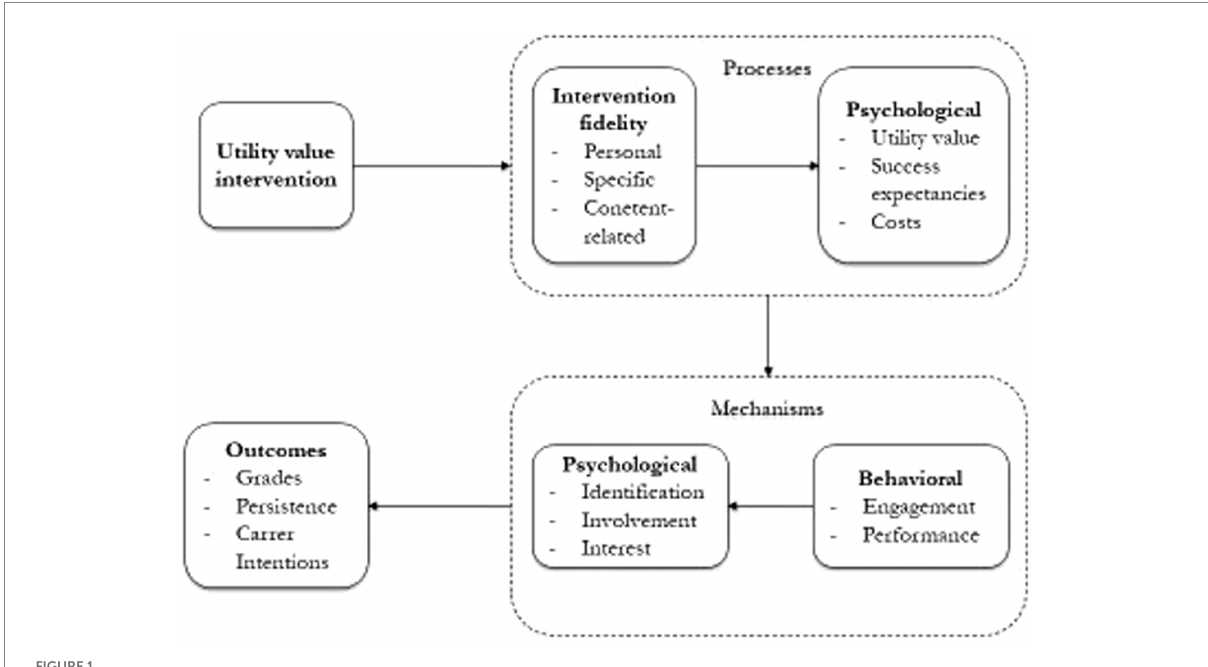
FIGURE 1 Utility value interventions logic model (Hulleman and Harackiewicz,